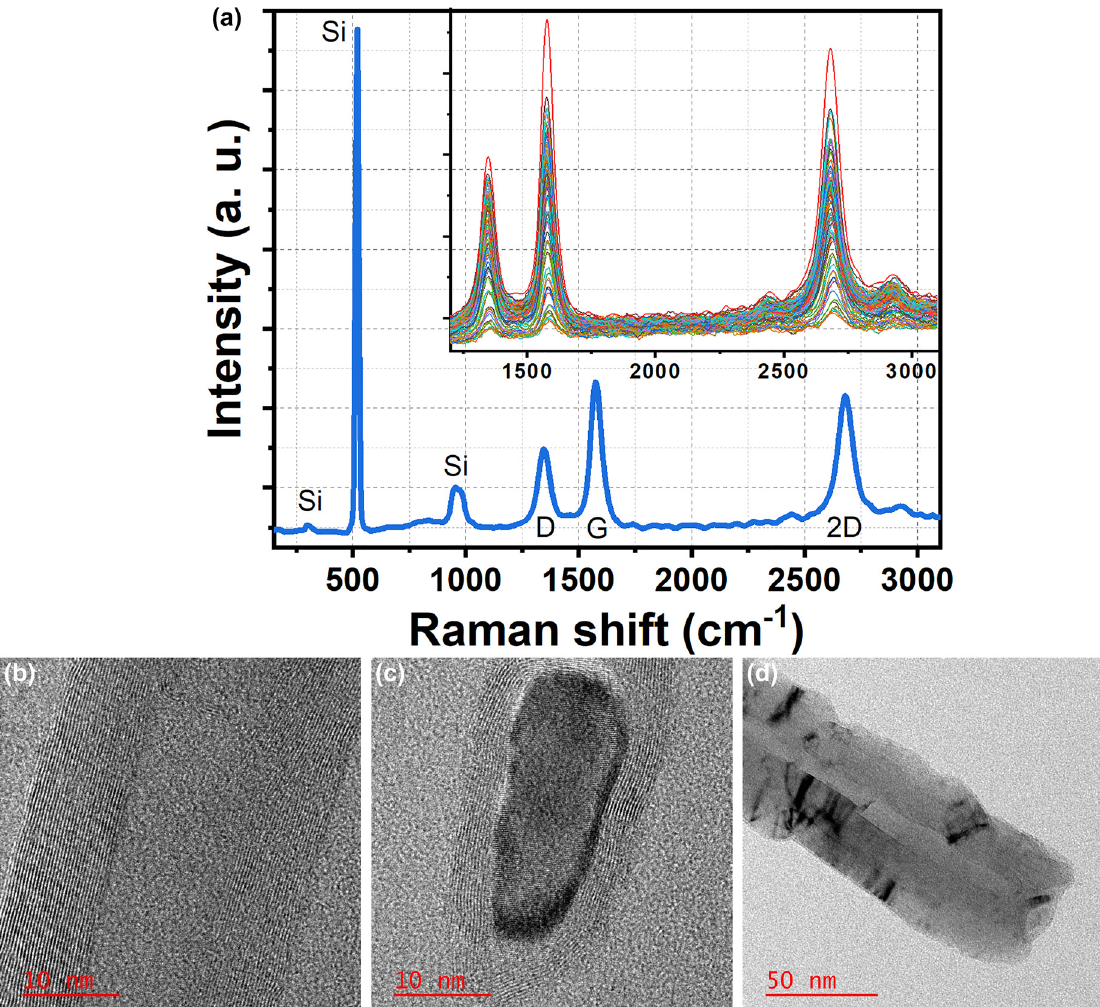
Figure 7: Characterizations of the ONF-CVD grown nanostructures. (a) A typical Raman spectrum of a sample including the grown nanostructures on top of the silicon tips. The inset shows the D-G regions of the resulted Raman spectra for the same sample, from an area of approximately 100 × 100 μ m 2 . The spectra are clearly demonstrating the characteristics of multi-wall carbon nanotubes. The Raman excitation wavelength is 532 nm. (b) High-resolution TEM image of the outer walls, containing 29 graphitic sheets, and the channel of a multi-wall carbon nanotube grown by the ONF-CVD process. (c) High-magnification image of a nanotube tip indicating encapsulated catalyst (Ni) nanoparticle, and the well-graphitized concentric sheets. (d) TEM image of a nanotube tip with the diameter of about 60 nm, revealing the hollow structure of the nanotube without the inclusion of the catalyst